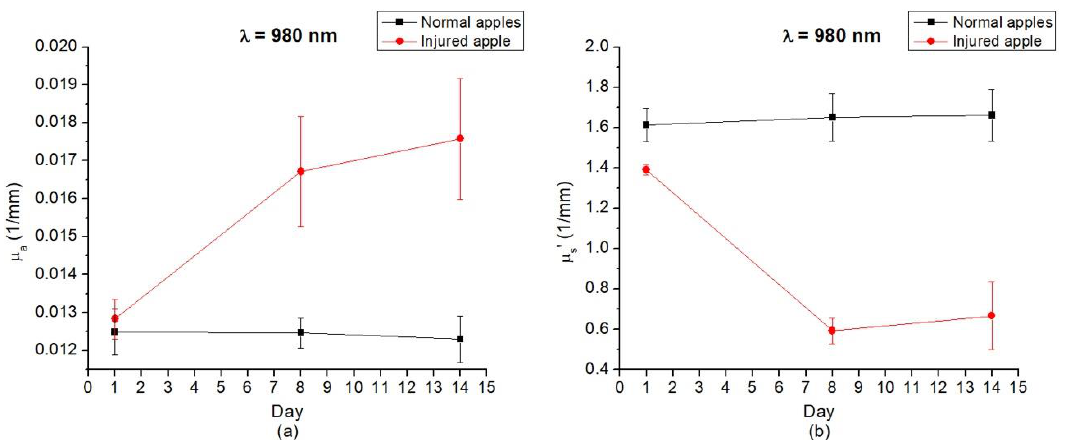
Figure 8. ( a ) Absorption and ( b ) reduced scattering coefficients of injured apples (red circles) and normal apples (black squares) recovered at the wavelength of 980 nm in 14 days. Table 2. Optical properties of normal apples and injured apple recovered at 980 nm in 14 days. Normal Apples (N = 5)